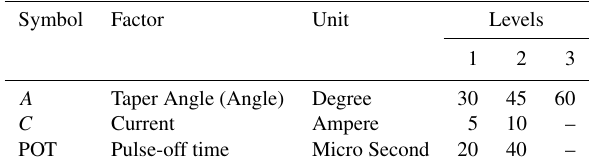
Table 2. Controllable factors, levels, and